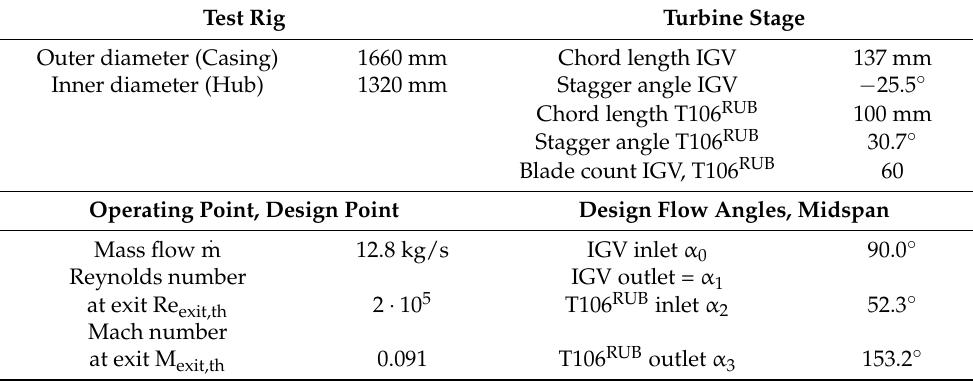
Table 4. Main test rig properties and turbine stage